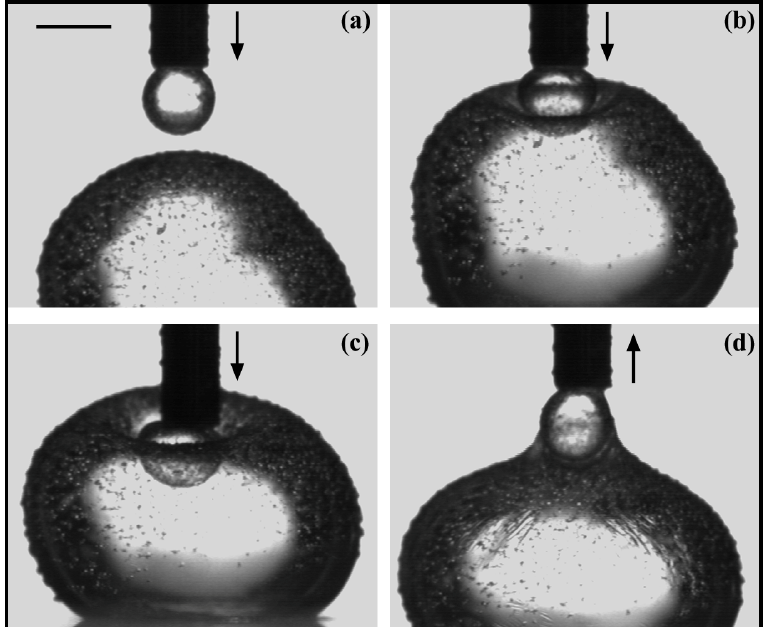
Figure 4. Visualization of the visco-elastic properties of lecithin at the oil/water interface. The system includes a silica particles-in-water dispersion (1%) and a solution of lecithin in sunflower oil (0.1%). From pictures ( a ) to ( c ), the needle is pushing down into the water droplet; on picture ( d ) the needle is pulling up out of the water droplet (the bar represents 2 mm). Reprinted with permission from Pichot et al. [44], Copyright (2012)